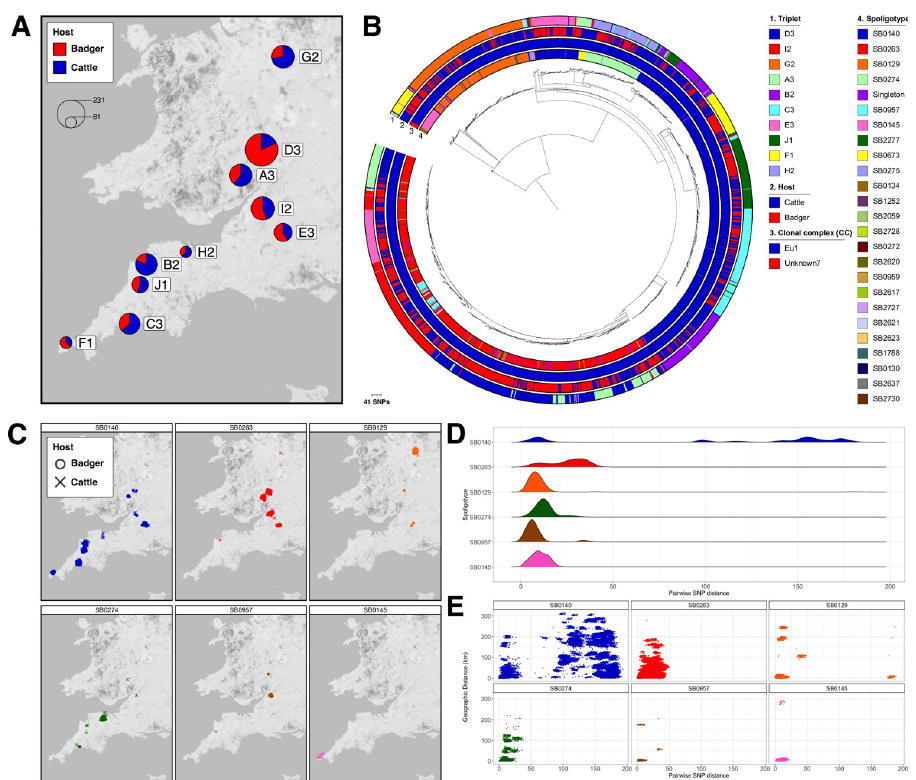
Fig 1. Genomic epidemiology of Randomised Badger Culling Trial (RBCT) dataset. A) Map showing location of isolation for 1,442 sequenced Mycobacterium bovis isolates. Isolates collected from badgers and cattle are shown in red and blue respectively. The proportion of samples from each host is shown in the pie charts and the pie charts are scaled according to the number of isolates. The RBCT triplet where each of the isolates were collected is labelled; B) Maximum likelihood phylogenetic tree of 1,442 M . bovis isolates rooted with isolates from the Unknown7 clonal complex. Trial area, host, clonal complex and spoligotype are shown as datastrips around the outside of the phylogenetic tree; C) Geographical distributions of the six most prevalent spoligotypes in the dataset. The host of each isolate is represented by a different shape: circle for badger and cross for cattle; D) Frequency distributions of pairwise SNP distances between all isolates belonging to the six most prevalent spoligotypes; E) Scatterplots of pairwise SNP distance against geographic distance in kilometres for all pairs of isolates belonging to the six most prevalent spoligotypes.